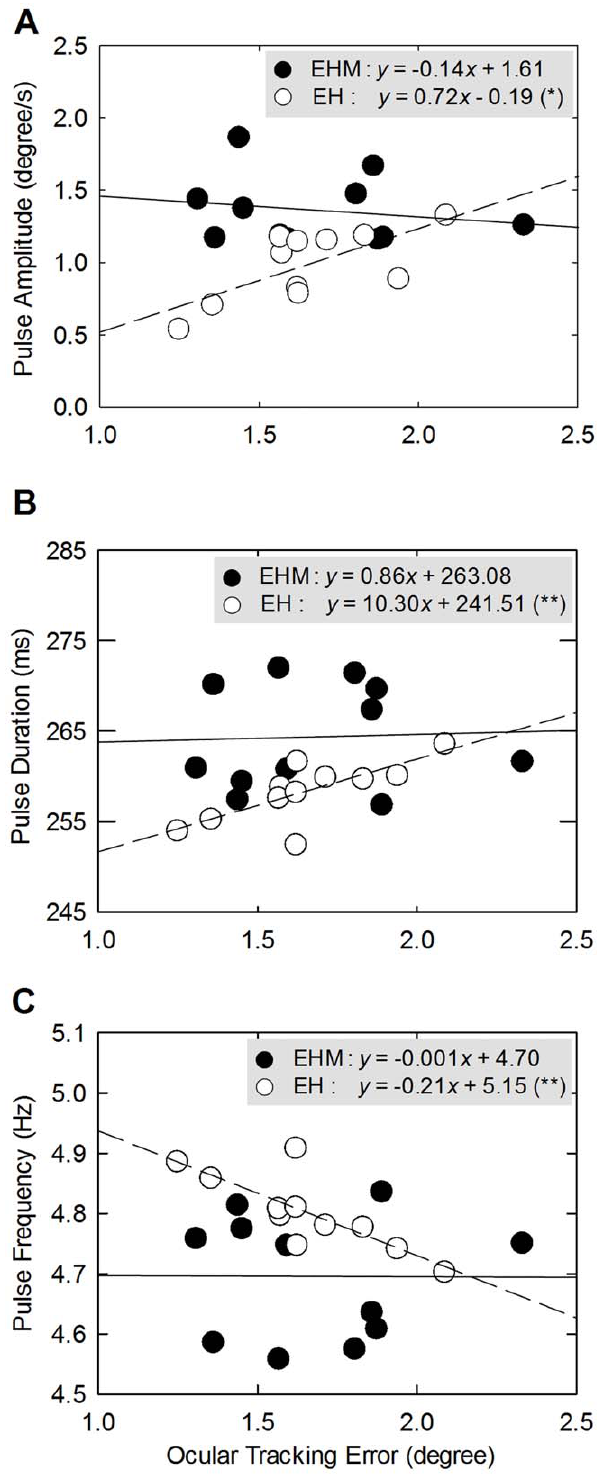
Figure 7. Scatter plots and regression lines of ocular tracking error versus speed pulse metrics. (A) amplitude, (B) duration, and (C) frequency of speed pulses under the EHM ( conditions. The symbol x in the equations represents ocular tracking error, and the symbol y represents speed pulse metrics in each plot of (A)-(C). (Significant regression slope: * : P , 0.05, ** : P ,